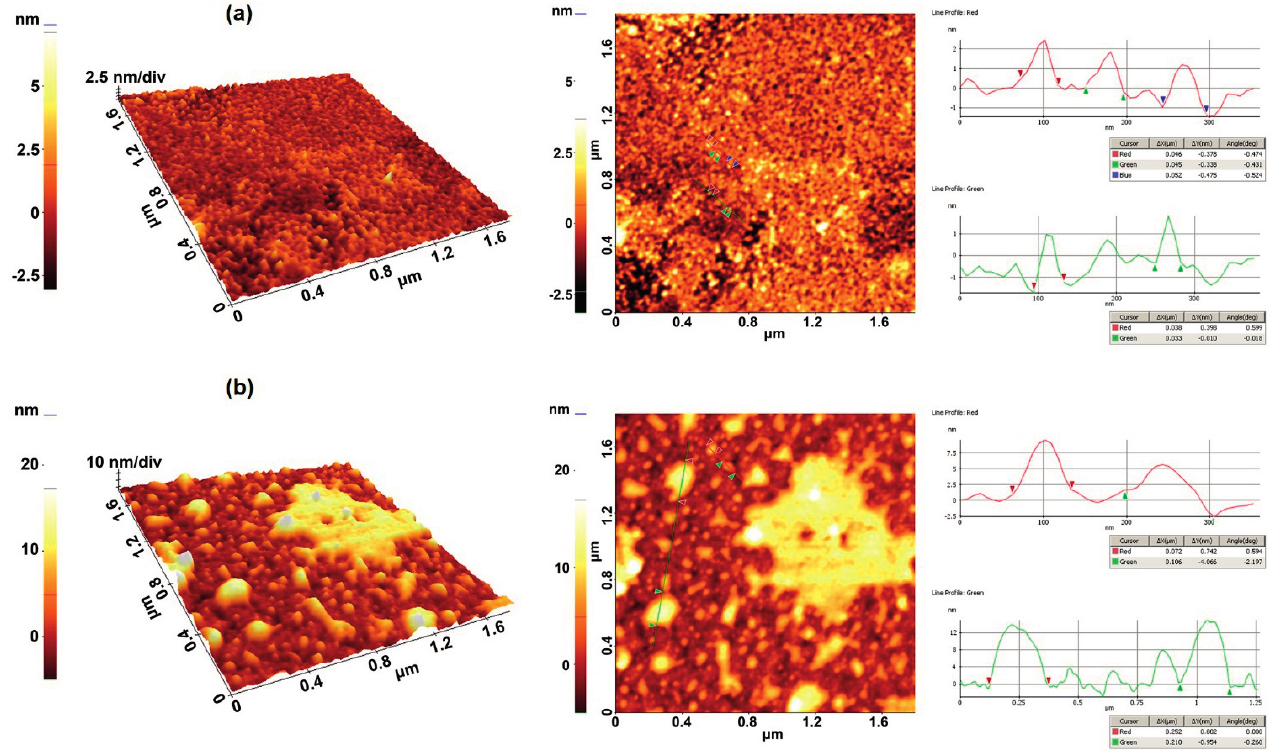
Figure 4. 3D ( left ) and 2D ( right ) AFM images for ( a ) bare gold thin films and ( b ) antibody